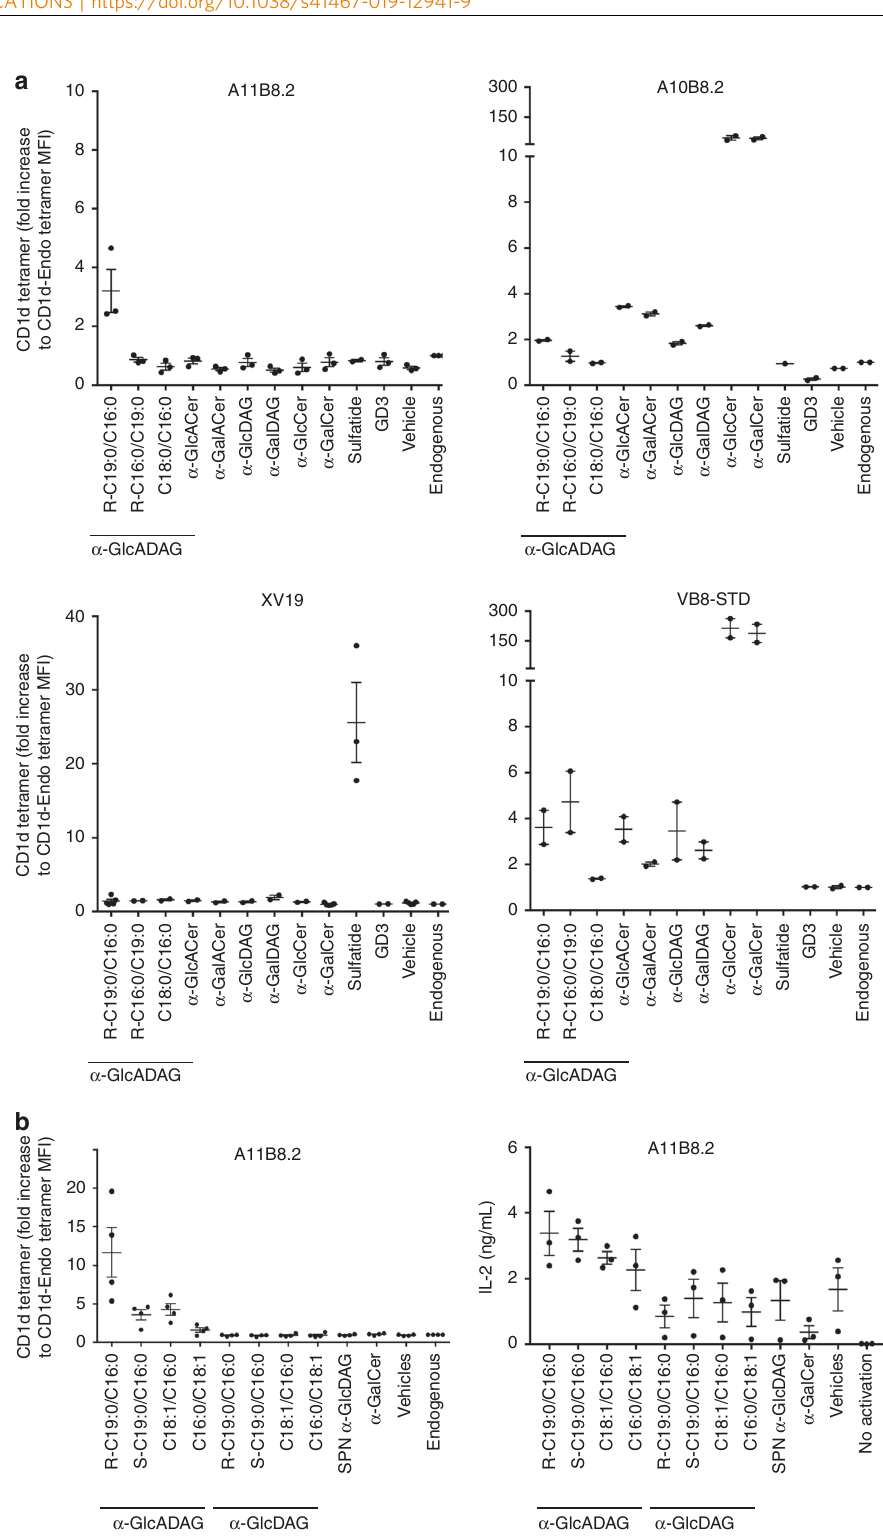
(Supplementary Table 3). Overall, the F ′ -pocket footprint of the α -GlcADAG-reactive type II NKT TCR ternary complex described here contrasted markedly with the previously determined A ′ -roof centric docking of the sulfatide-reactive type II NKT